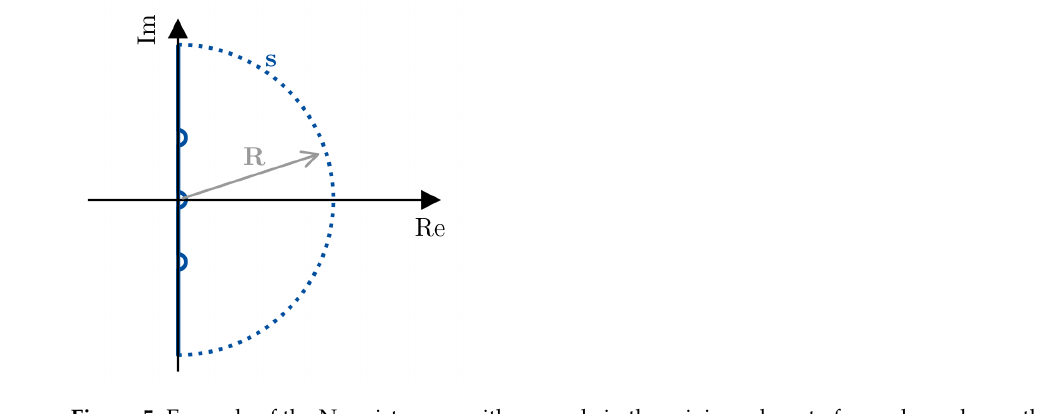
Figure 5. Example of the Nyquist curve with one pole in the origin and a set of complex poles on the imaginary